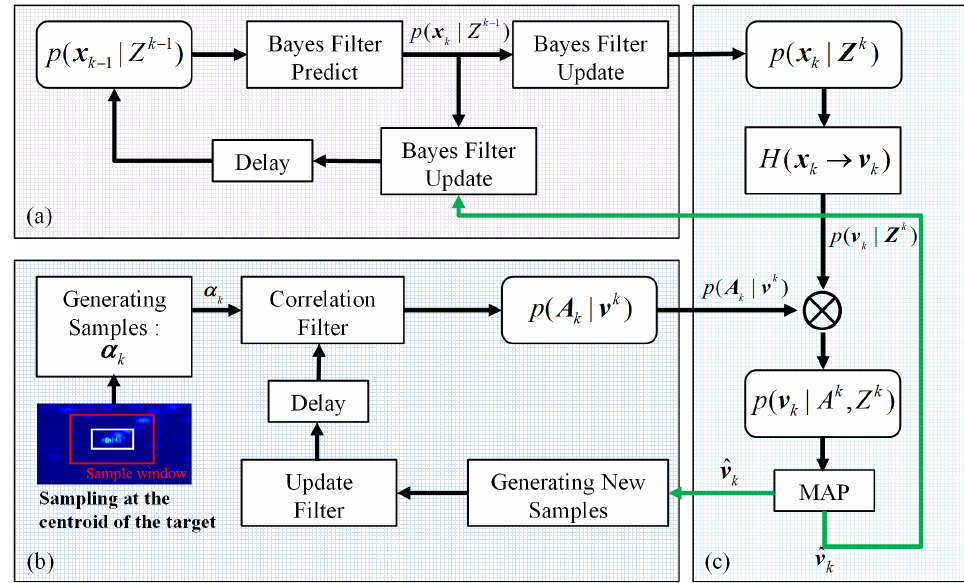
Figure 1. Overall flow of the proposed method. ( a ) Bayes filter module. ( b ) Correlation filter module. ( c ) Fusion module. The green lines indicate the feedback for correcting measurements. Both the process of providing measurements for Kalman filter by detector and the training process of the correlation filter are omitted in the